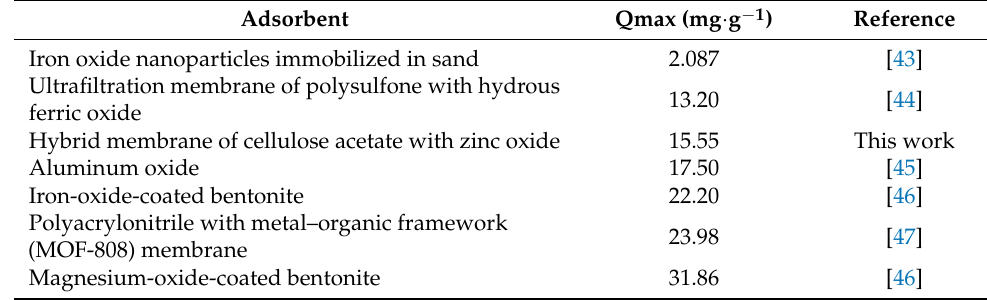
Table 4. Comparison of maximum capacity adsorption of lead by different adsorbents.